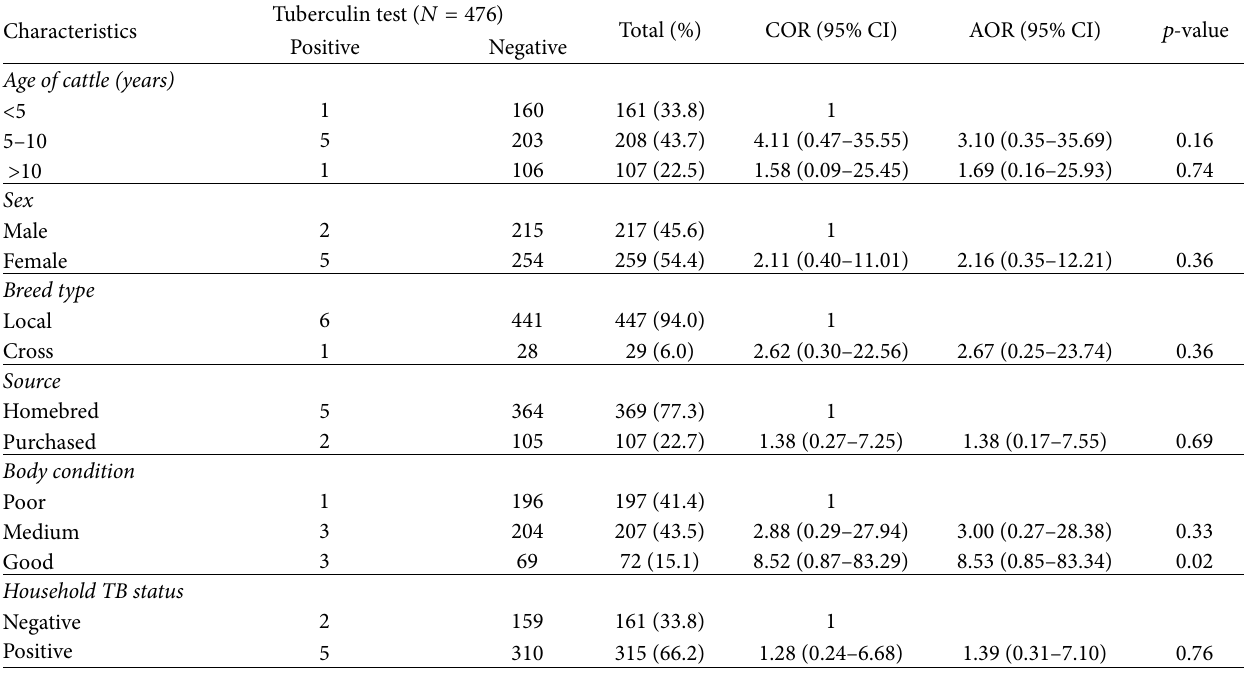
Table 2: Association of host risk factors with bovine tuberculin test reactivity in cattle based on a ≥2 mm cut-off value, South Gondar Zone, northwest Ethiopia